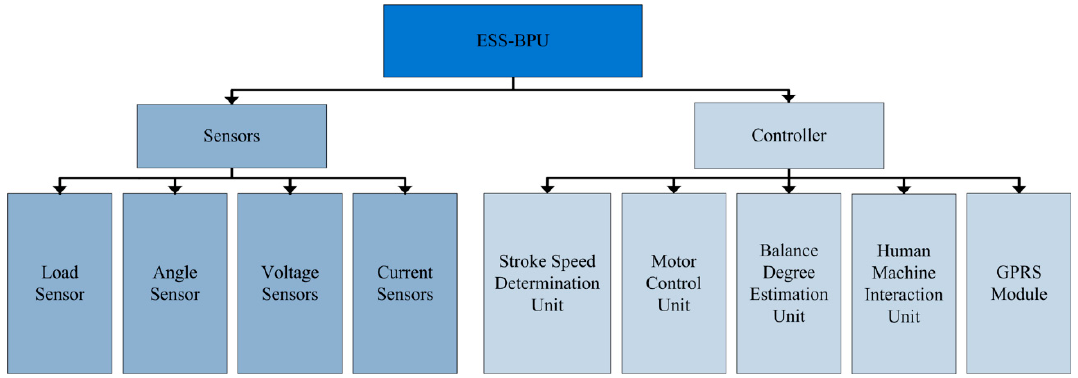
Figure 2. Main hardware components of the energy saving system.